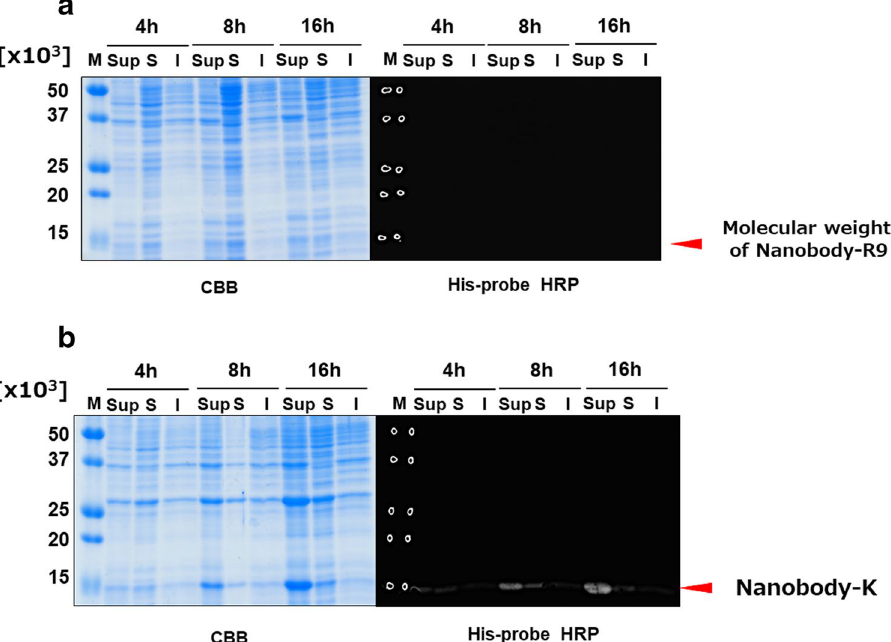
Figure 2. Expression analysis of Nanobody-R9 ( a ) and Nanobody-K ( b ) in E. coli . The figures show SDS-PAGE analysis (Left panels) using Coomassie Brilliant Blue (CBB) detection and western blot analysis (Right panels) using His-probe HRP detection of culture supernatant (Sup), intracellular soluble fraction (S), and intracellular insoluble fraction (I) under the induction at 28 °C for 4–16 h. M show Low molecular weight marker. The arrows indicate the deduced molecular weights of the target proteins. Complete gels and western blots are presented in Supplementary Fig. 1.